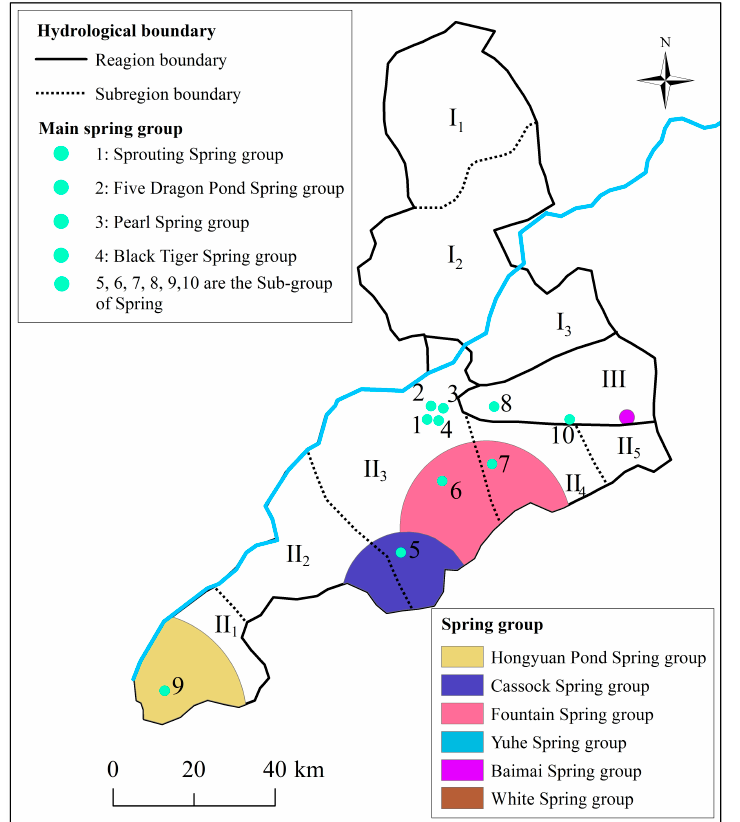
Int. J. Environ. Res. Public Health 2017 , 14 , 1114 Figure 4. Spatial distribution of the karstic spring group in Jinan City. Figure 4. Spatial distribution of the karstic spring group in Jinan City. Table 1. Table of hydrogeological partition of Jinan karstic spring region.